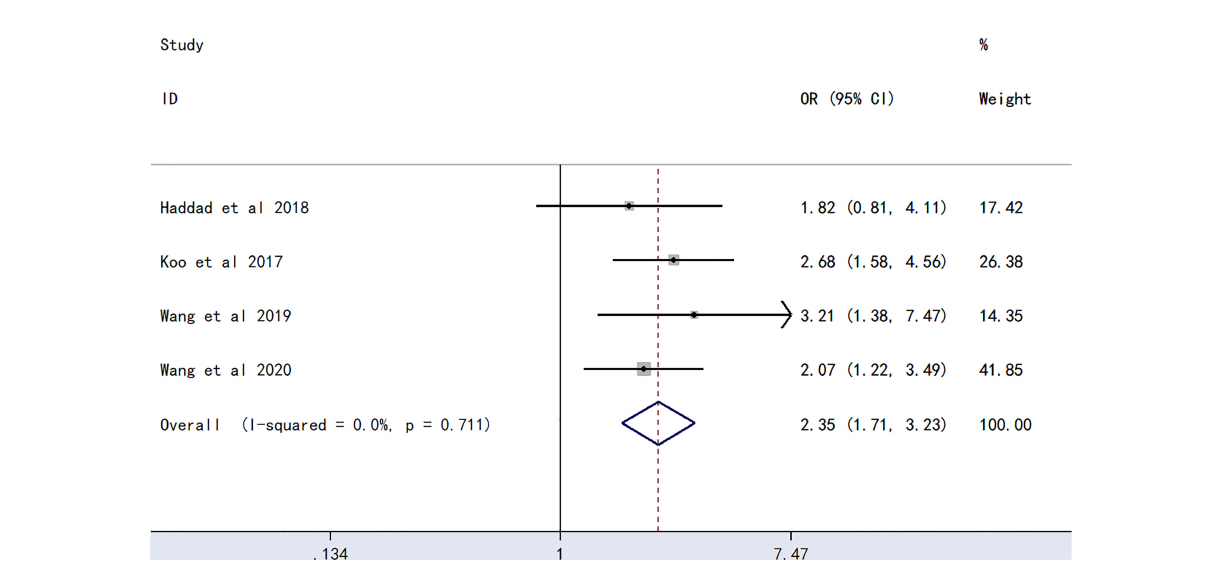
FIGURE 4 | Forest plot evaluating the association between PICC-associated VTE and the prevalence of B blood